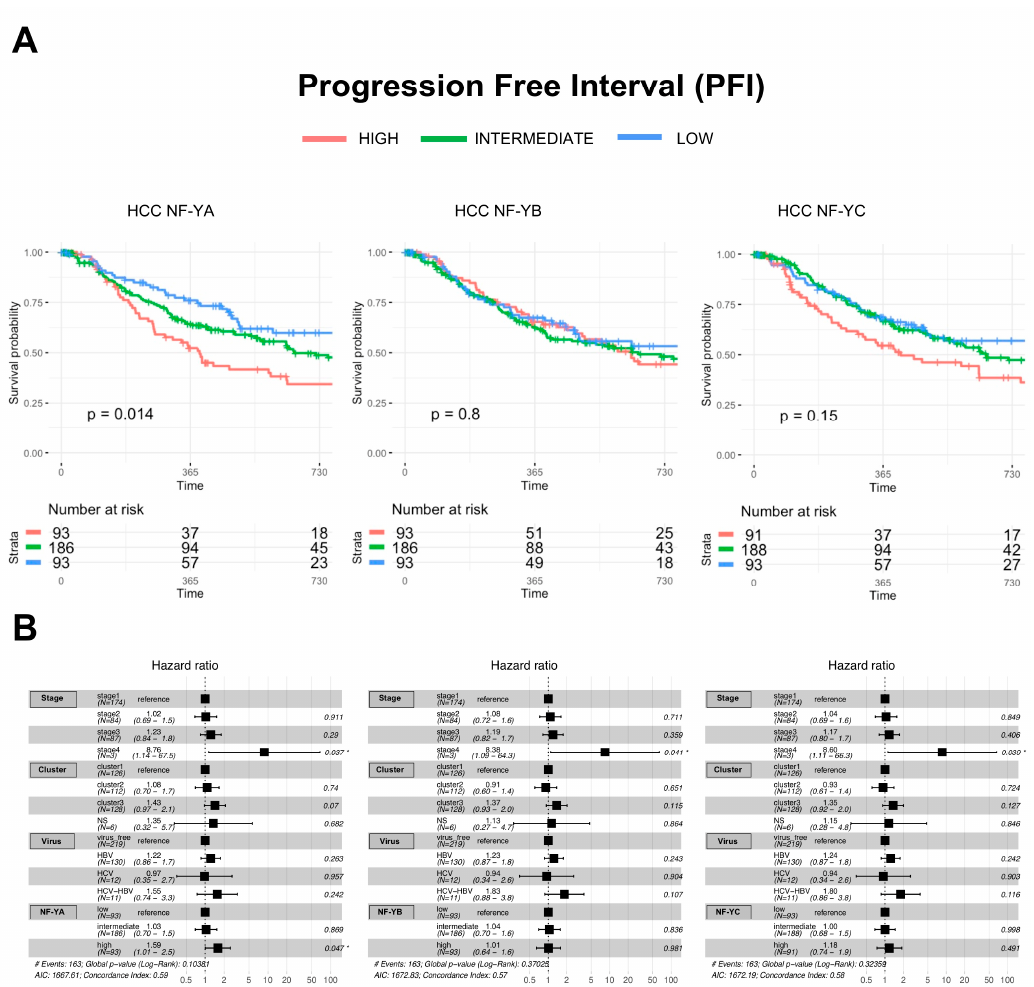
Figure 6. Clinical outcome of HCC tumors with different NF-Y subunits levels. ( A ) Progression-Free-Interval curves of HCC tumors with stratification according to quartiles distribution of NF-Y subunits expression (Intermediate, High and Low). ( B ) Hazard ratios of the sample cohorts partitioned according to Stage (I–IV), iClusters, viral infection and NF-Y levels (low is set as reference).